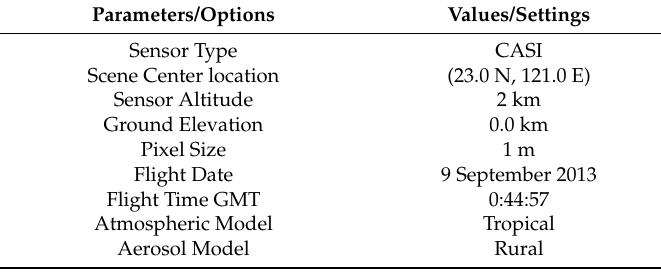
Table 1. The parameters and options specified in Fast Line-of-sight Atmospheric Analysis of Hypercubes (FLAASH) for atmospheric correction.